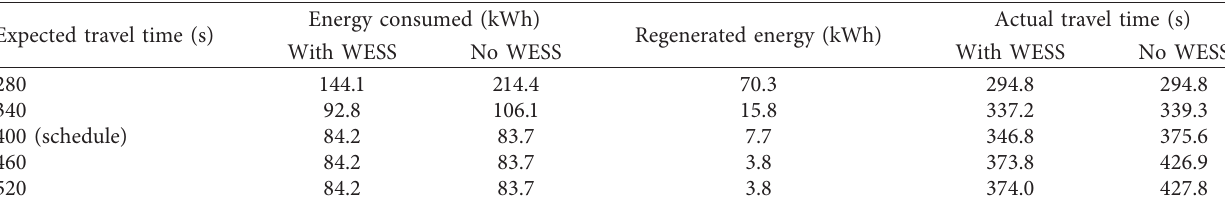
Figure 6: Optimized speed profiles for various expected travel times (seconds). Table 3: Minimized energy consumption for various travel